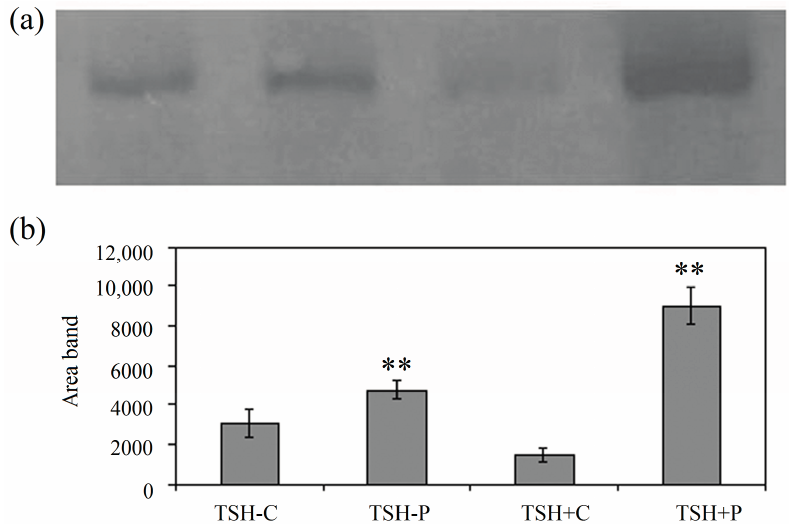
Figure 1. Bax analysis in quiescent control sample (TSH − C) and quiescent proton-irradiated sample (TSH − P), in proliferating control sample (TSH+C) and proliferating proton-irradiated sample (TSH+P). C, control; P, proton. ( a ) Immunoblots of proteins (30 µg) were probed with anti-Bax antibodies (apparent molecular weight 23 kDa) and visualized by ECL; ( b ) The area density was evaluated by densitometry scanning and analysed with Scion Image; data represent the means ± S.D. of four separate experiments. irradiated samples significance ** p < 0.01 versus